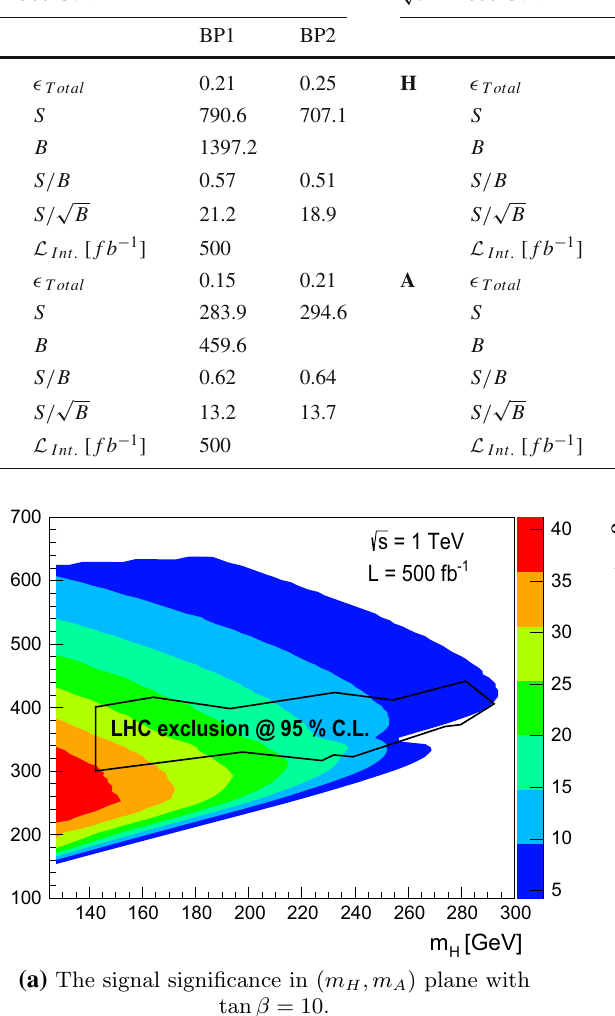
Fig. 6 Discovery contour in a ( m H , m A ) plane, b ( m A , tan β )